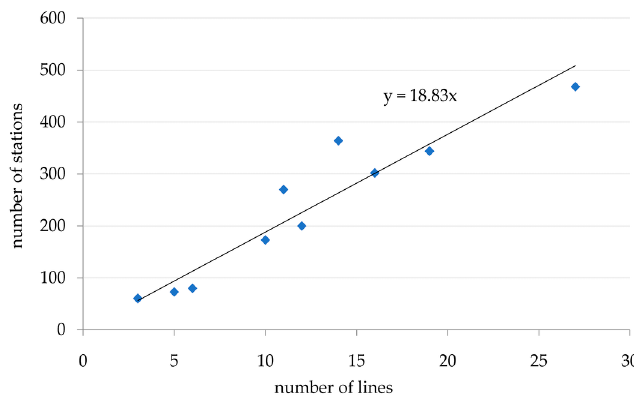
Figure 3. Dependency between the number of metro lines and the number of the stations.